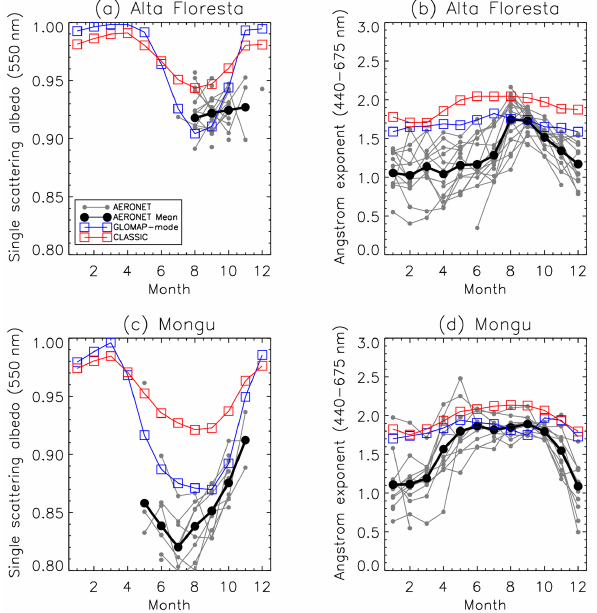
Figure 12. Seasonal cycle of moist aerosol optical properties (single scattering albedo and Ångström exponent). AERONET data from Alta Floresta (southern Amazonia) and Mongu (southern Africa) in- clude all available monthly means (grey) and the long-term monthly mean (black) for months with good data coverage (see text). Co- located model data from GLOMAP-mode (red) and CLASSIC (blue) are shown taking the column average long-term monthly